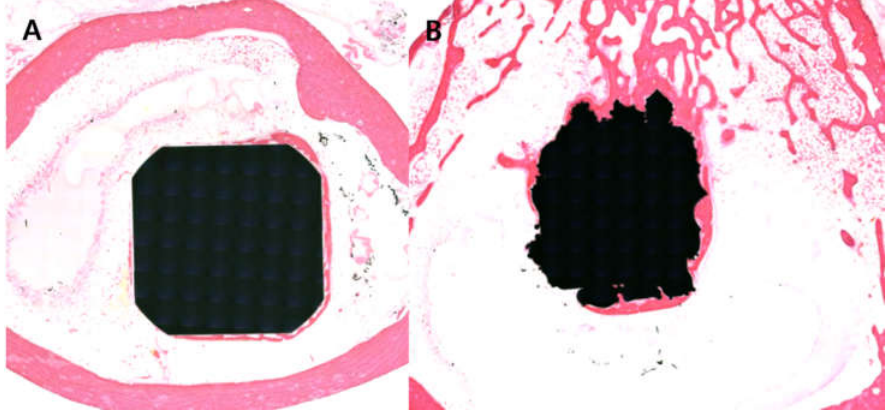
Figure 5. Light microscope images revealing the bone-to-implant contact of ( A ) the SUS-machined (×12.5) and ( B ) SUS-DMF (×12.5) samples. The bone-to-implant contact of the DMF group was superior to that of the machined group.